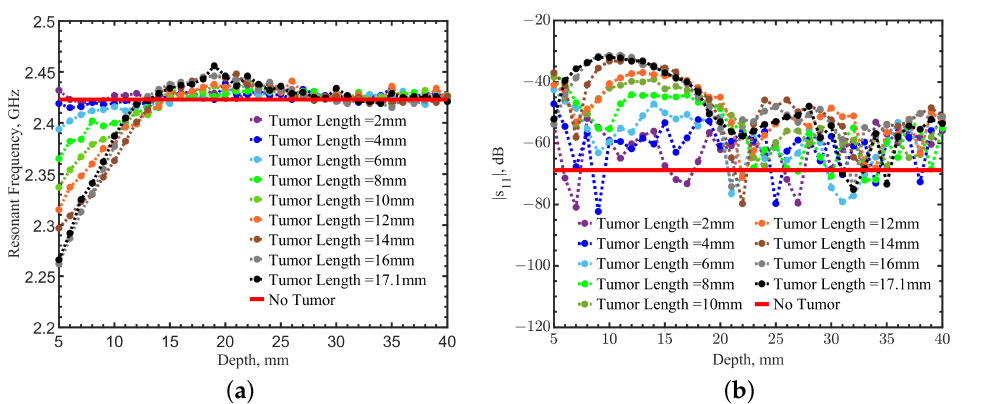
Figure 3. Comparison of simulations with tumor cubic lengths from 2 to 17.1 mm at a depth range from 5 to 40 mm: ( a ) resonant frequencies and ( b ) magnitudes of reflection